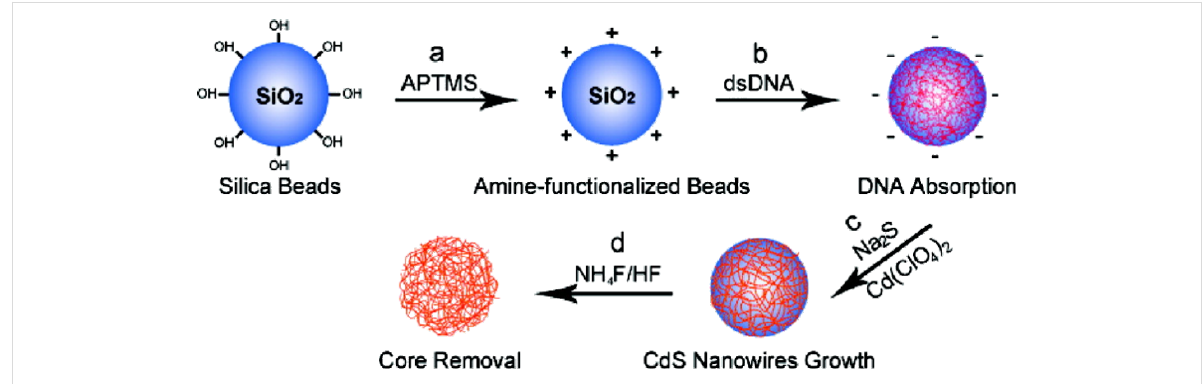
Figure 3: DNA-templated preparation of porous CdS shells on the surface of silica beads: (a) surface modification with (3-aminopropyl)trimethoxysi- lane (APTMS), (b) DNA deposition on the cationic particle surface, (c) CdS precipitation, and (d) dissolution of the SiO 2 core to form hollow structures. Reprinted with permission from [52]. Copyright 2011 American Chemical